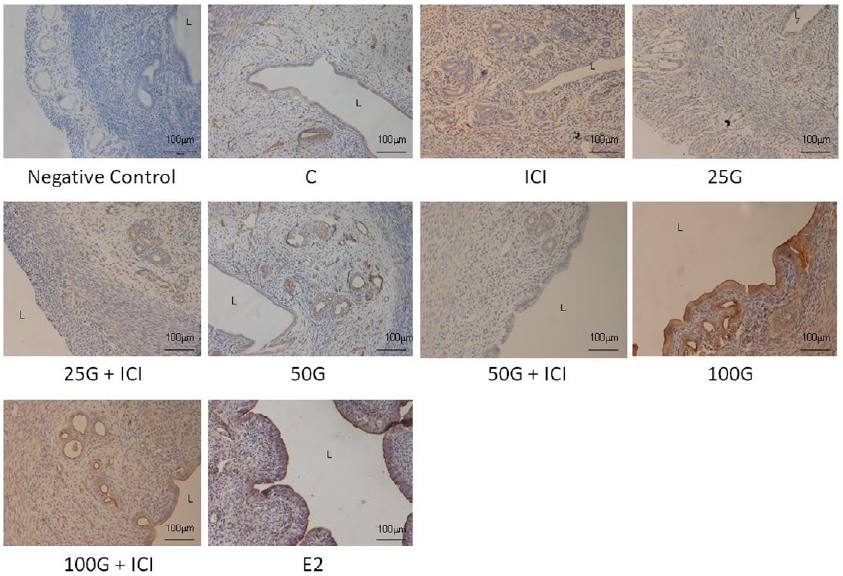
Figure 4. The distribution of SLC26A6 in the uterus of rats receiving various genistein doses (25, 50 and 100 mg/kg/day with and without the presence of ICI 182780, an estrogen receptor antagonist). An increase in SLC26A6 immunostaining intensity was seen at the apical membrane of the luminal and glandular epithelia with increasing doses of genistein. The intensity was reduced following concomitant administration of ICI 182780. High apical intensity was observed in the estrogen treated group (positive